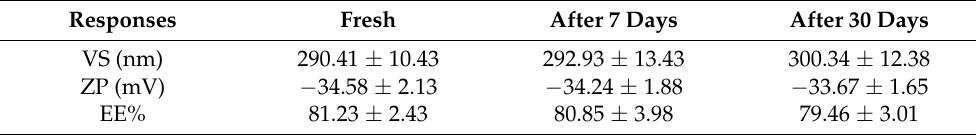
Table 5. The effect of storage at 4 ◦ C for one month on VS, ZP, and EE% of the optimized formula. Responses